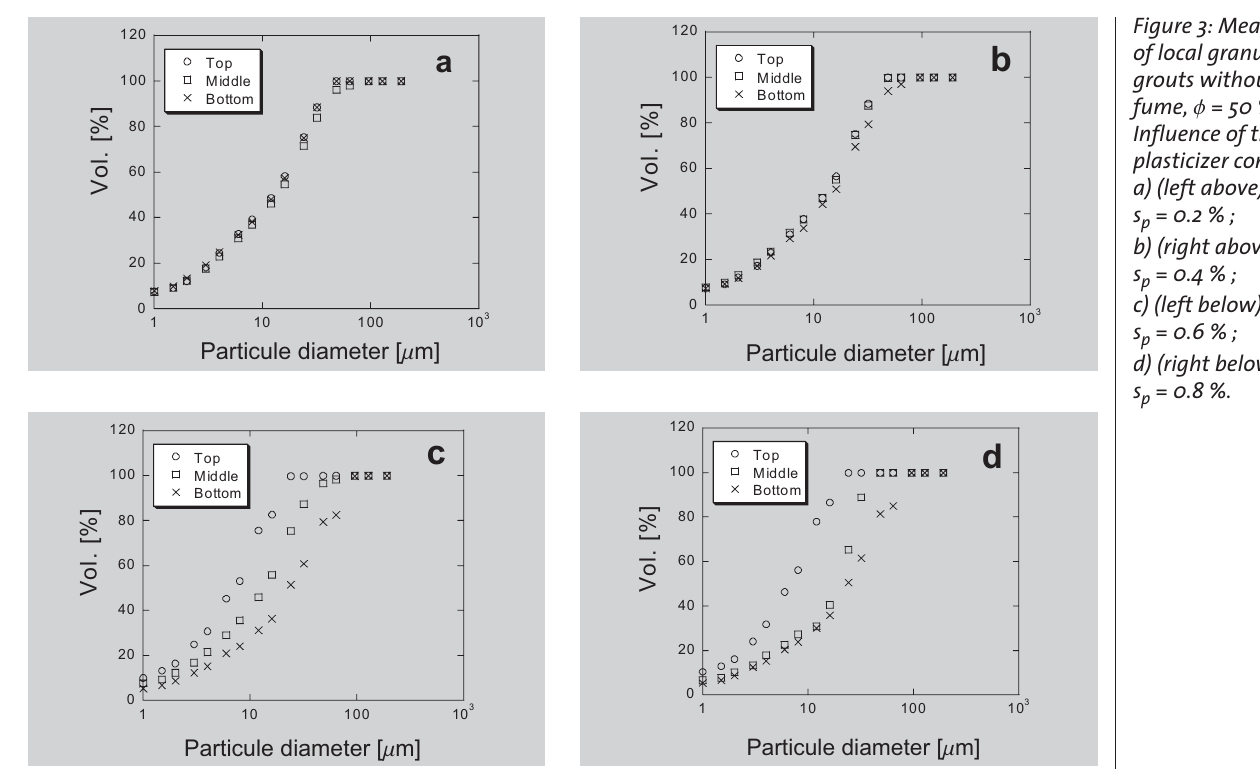
Figure 3: Measurement of local granularity of grouts without silica fume, f = 50 %. Influence of the super- plasticizer concentration: